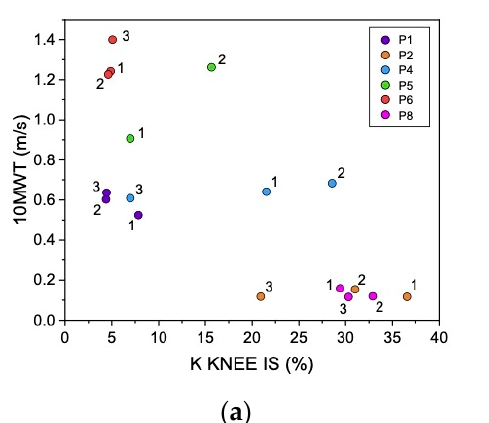
session against the walking tests results (10MWT and TUG) (Figure 5).